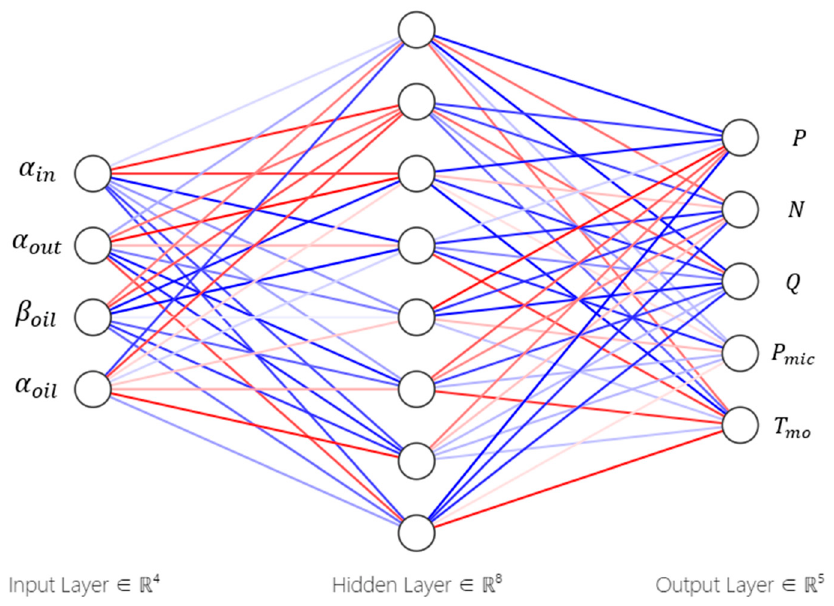
Figure 4. The schematic diagram of RBF-NN.